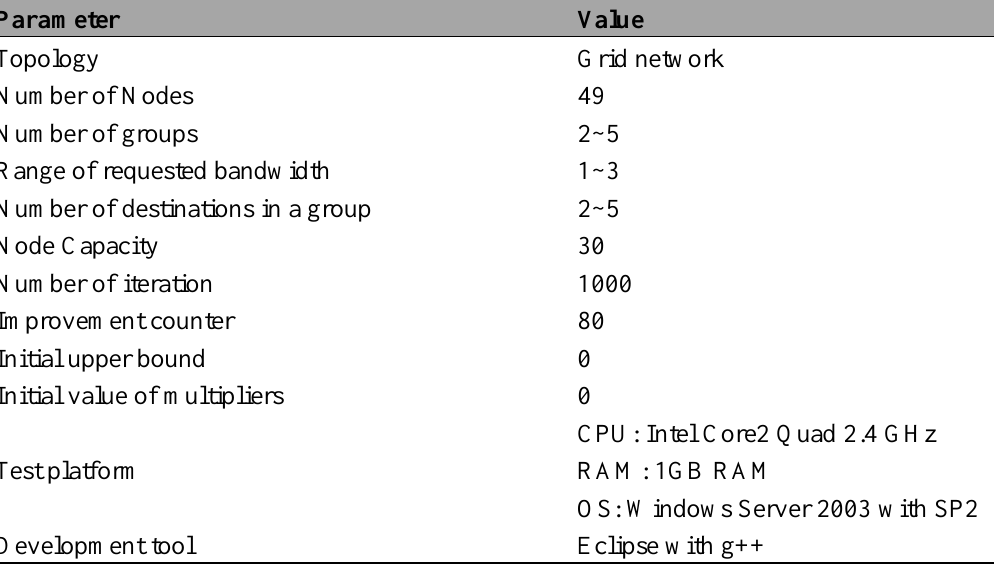
Table 3. Experiment environment and